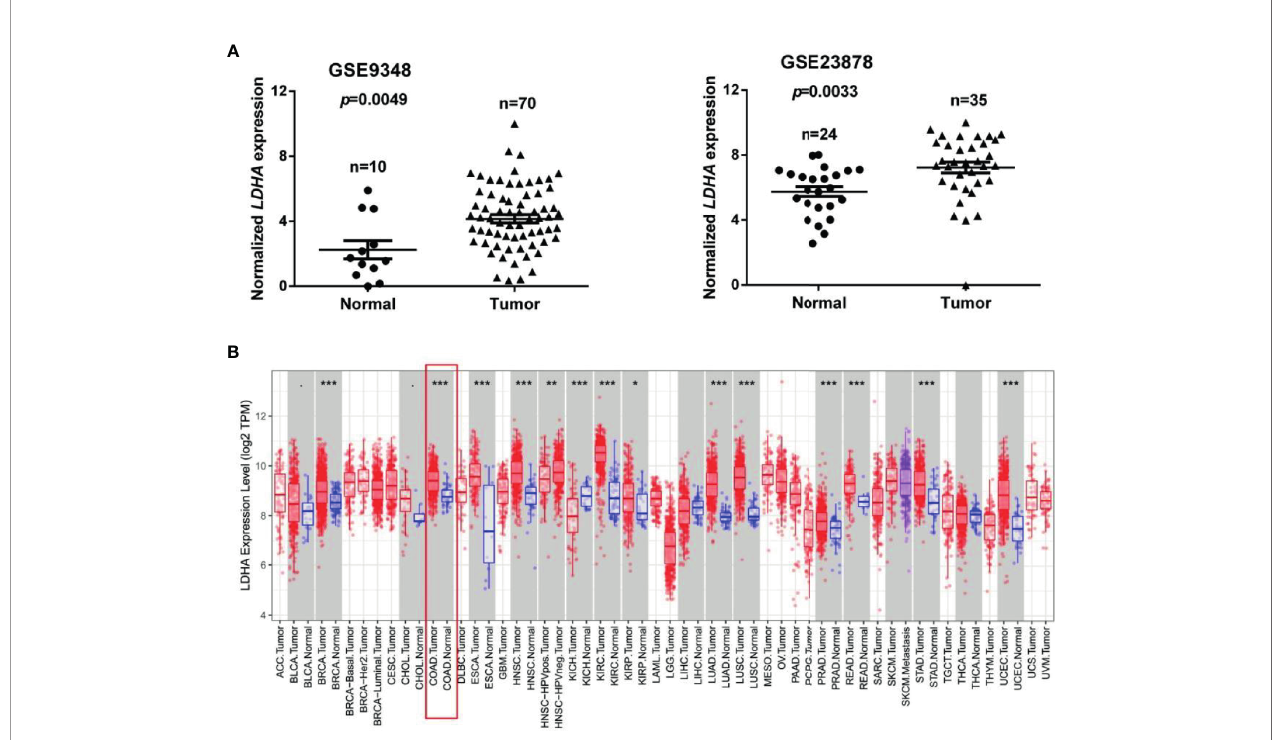
FIGURE 1 | LDHA is highly expressed in COAD. (A) The expression level of LDHA in COAD in two GEO datasets (GSE9348: 10 normal samples and 70 COAD samples; GSE23878: 24 normal samples and 35 COAD samples). (B) Relative expression of LDHA in different cancers compared with normal tissues in the Oncomine database. * p < 0.05, ** p < 0.01, *** p < 0.01 compared with